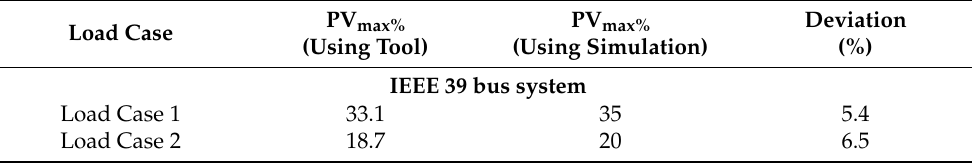
Table 7. Validation results for test system with emulated PV